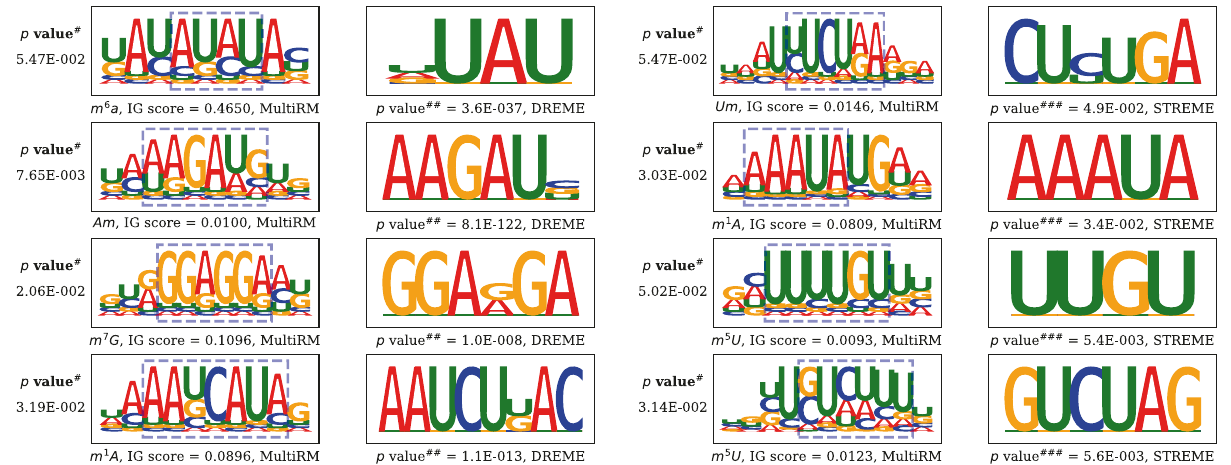
Fig. 2 Motif matching. Some motifs identi fi ed from MultiRM are similar to those identi fi ed from conventional motif analysis (DREME and STREME). p value # was calculated using TOMTOM by utilizing a null model containing MultiRM ’ s motif columns from all the columns in the set of DREME and STREME motifs. p value ## in DREME was calculated by a one-sided fi sher ’ s exact test. p value ### in STREME was calculated by a one-sided binomial test. The motifs within the blue dashed anchor boxes were extracted to do pair comparisons. IG scores were calculated by the average of the contribution scores of each nucleotide obtained by the integrated gradients method. Accession codes for the data used to generate this fi gure are found in Table 5.